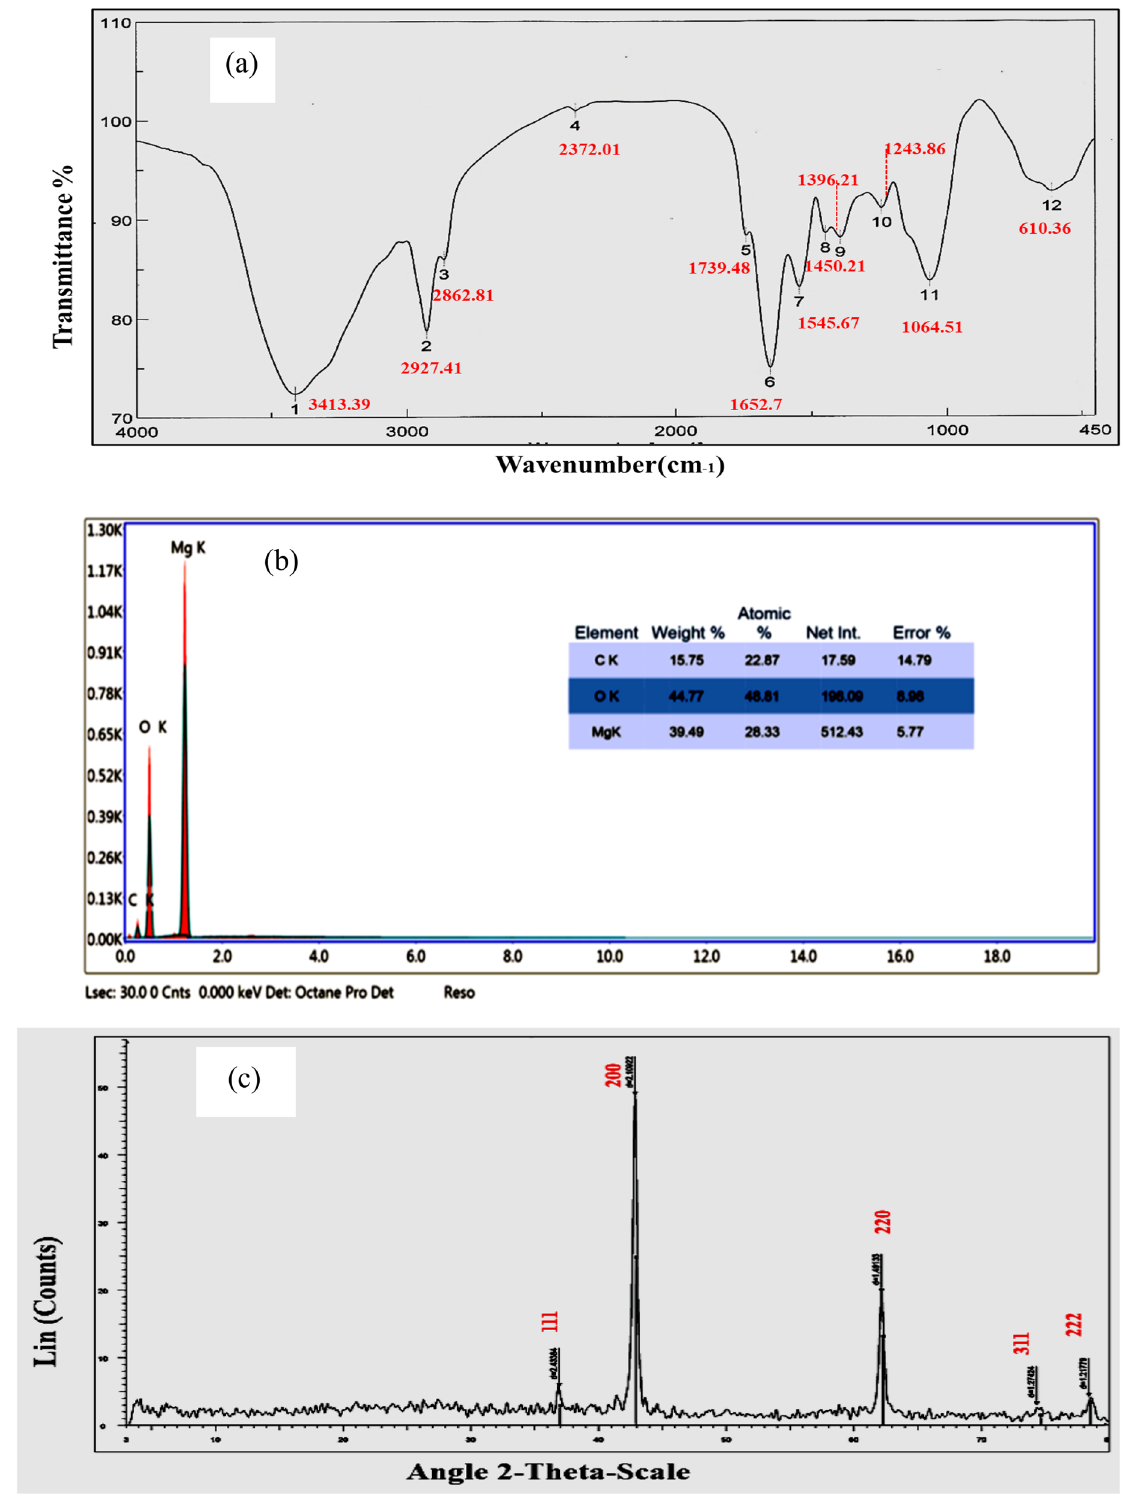
Figure 2. (a) FTIR spectrum of RcNps (b) EDX spectrum of of RcNps (c) XRD pattern of